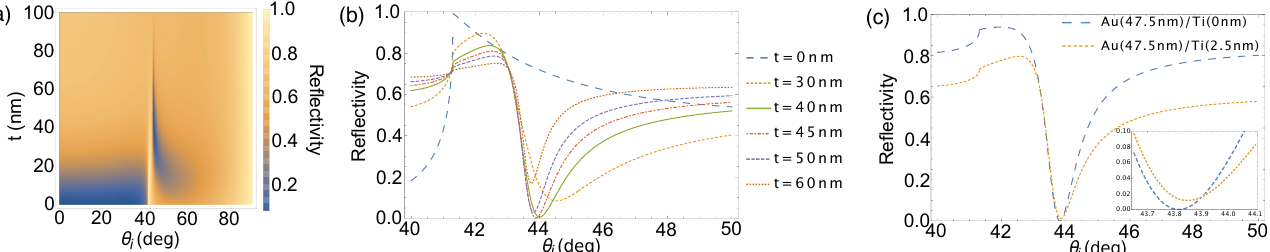
Figure 1. ( a ) Angular reflectivity spectrum for a BK7/Ti/Au/air structure with varying Au film thickness with collimated incident beam for an angular range from normal incidence to grazing incidence; ( b ) representative plots at several Au film thicknesses; ( c ) comparison of reflectivity spectra with (yellow dashed line) and without (blue dashed line) the Ti adhesion layer. The inset shows a magnified area at the reflectivity dip to distinctly see the difference between the two plots.